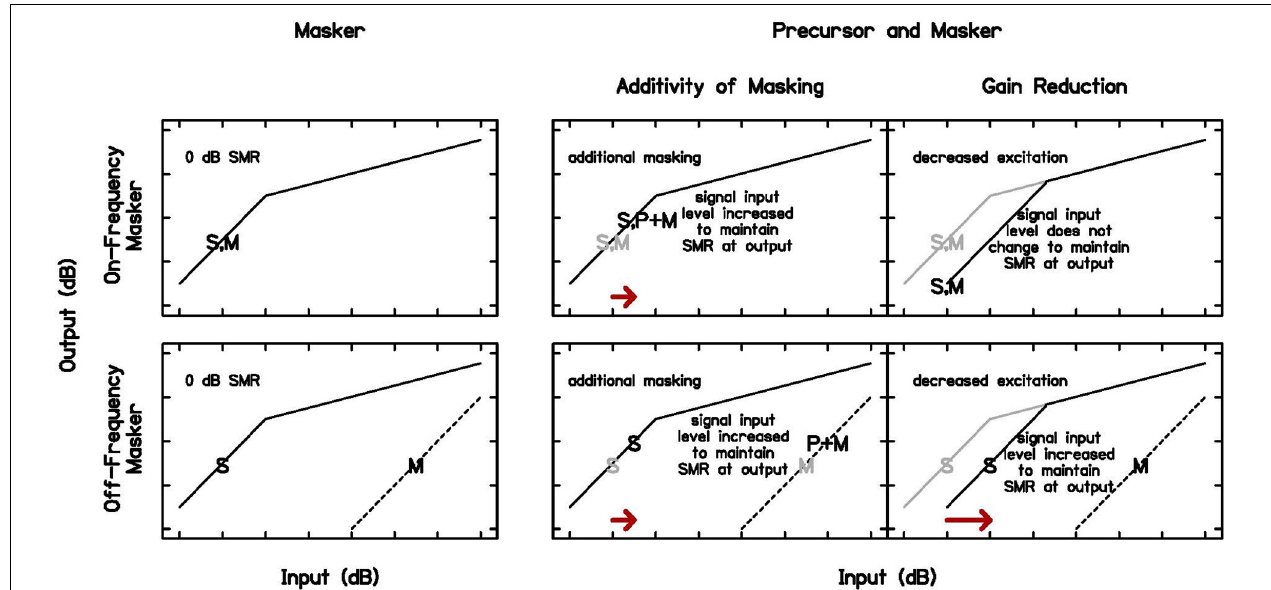
FIGURE 2 | Schematic of cochlear input-output functions and threshold predictions in Experiment 1. Signal threshold (S) occurs at a criterion signal-to-masker ratio (SMR), in this case 0 dB (first column) for an on-frequency (top row) and off-frequency (bottom row) masker (M). With the addition of a precursor (P), predictions differ for forward masking due to additivity of masking or gain reduction. With additivity of masking (second column), a similar shift in signal threshold is expected when the same precursor is presented with equally effective on- and off-frequency maskers (arrows in second column). With gain reduction (third column), a larger shift in signal threshold is expected in the off-frequency case, since the masker is not affected by gain reduction at the signal frequency place (arrow in third column). The input-output functions, S, and M from the first column are repeated in gray in the second and third columns to illustrate the predicted changes with the introduction of a